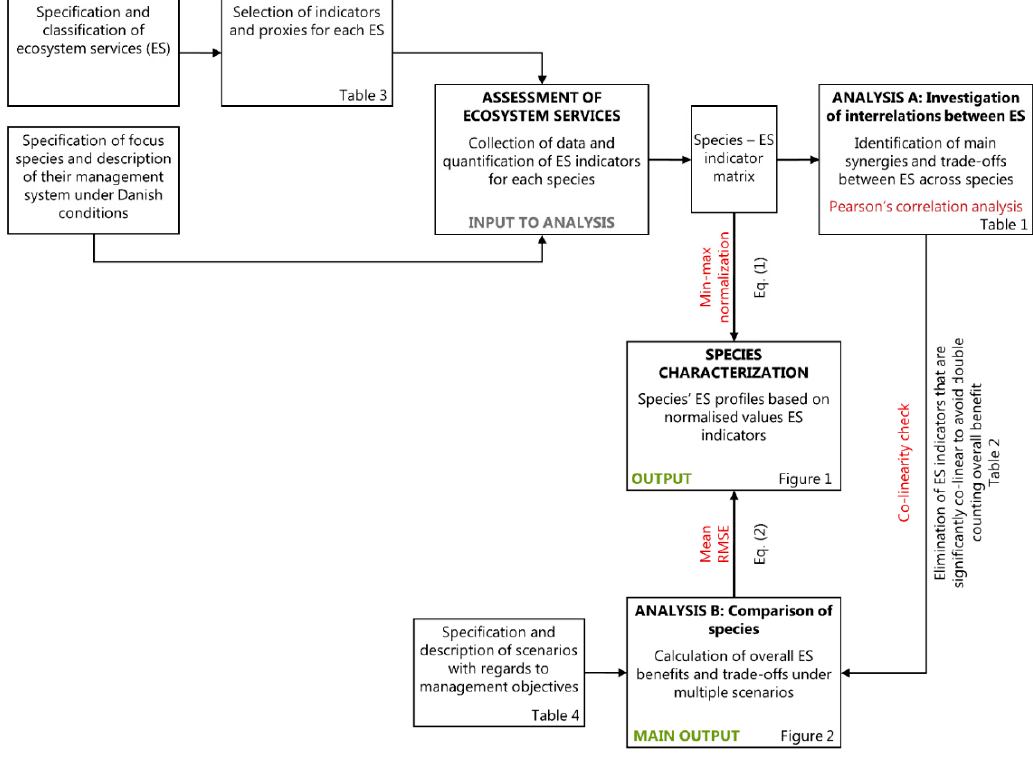
Table 1. Selection of ecosystem services included in the analysis, with their assigned indicators or proxy along with their unit of